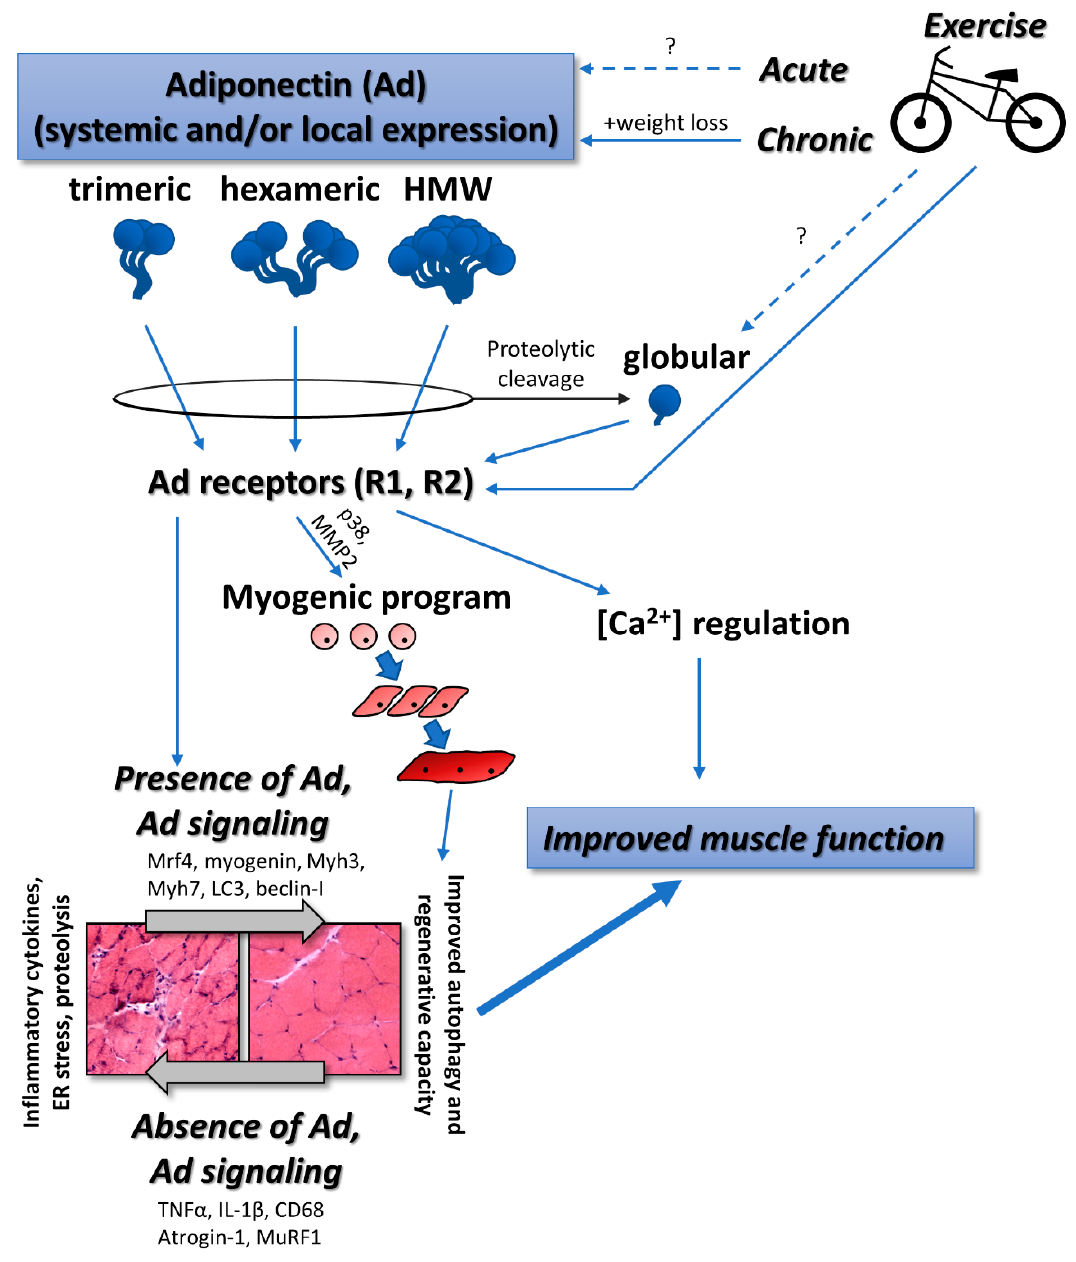
Figure 1. Proposed relationships between adiponectin, exercise, and skeletal muscle function. Multiple isoforms including the proteolytically cleaved globular isoform signal to tissue including skeletal muscle, satellite cells, myoblasts, and differentiated myotubes. Physical exercise generally stimulates increases in adiponectin expression and signaling. Skeletal muscle health is ultimately improved with sufficient adiponectin signaling via improved cellular functions such as autophagy and regeneration and suppression of inflammation, endoplasmic reticulum (ER) stress, and proteolysis. Solid arrows represent relationships, effects, or interactions that are clearly defined in the literature. Broken arrows with “?” represent relationships, effects, or interactions that are not clearly defined in the literature.